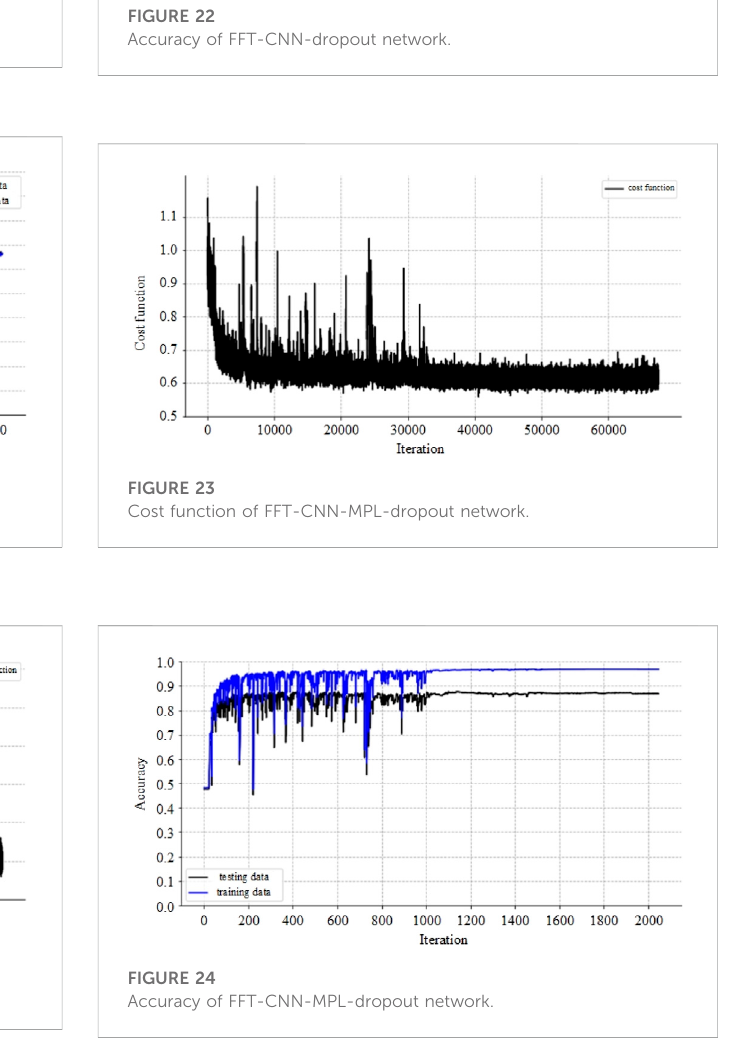
FIGURE 19 Cost function of CNN-dropout network.